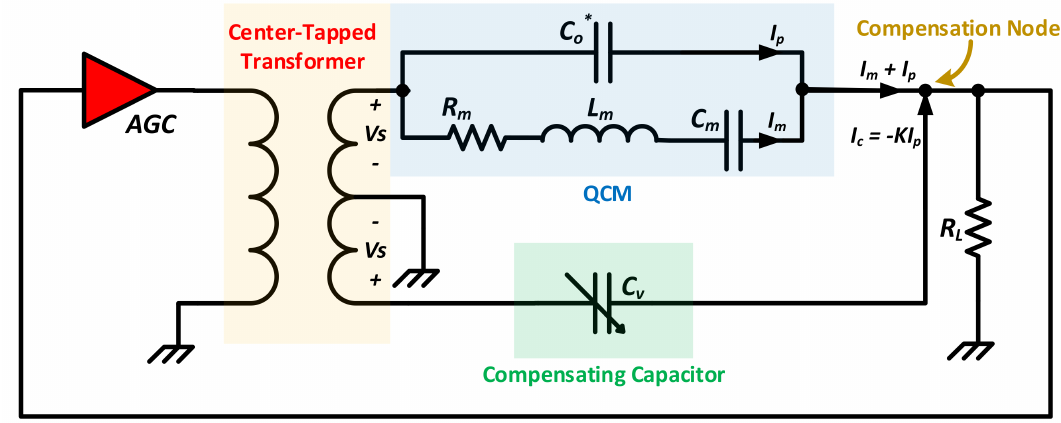
Figure 15. QCM oscillator with parallel capacitance compensation from SRS